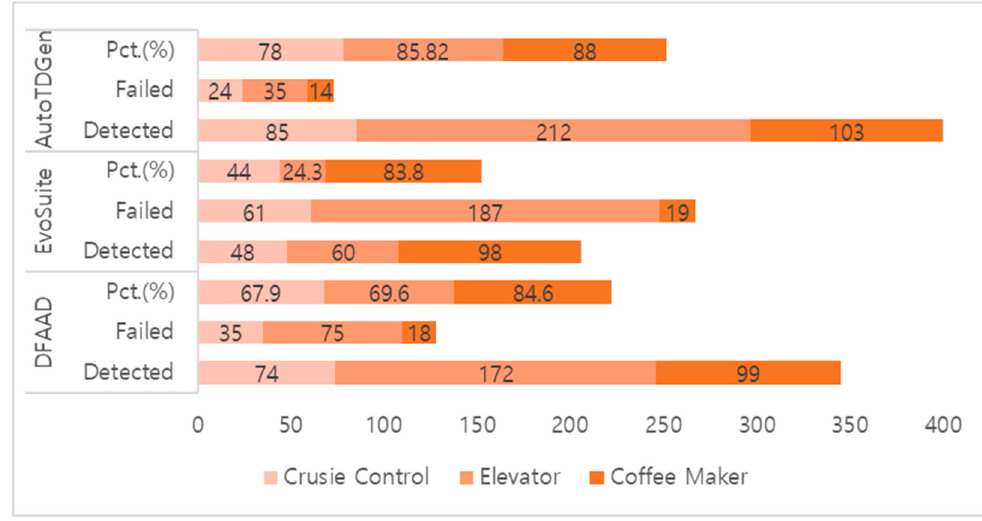
Figure 5. The percentage and number of mutants detected and failed to detect.